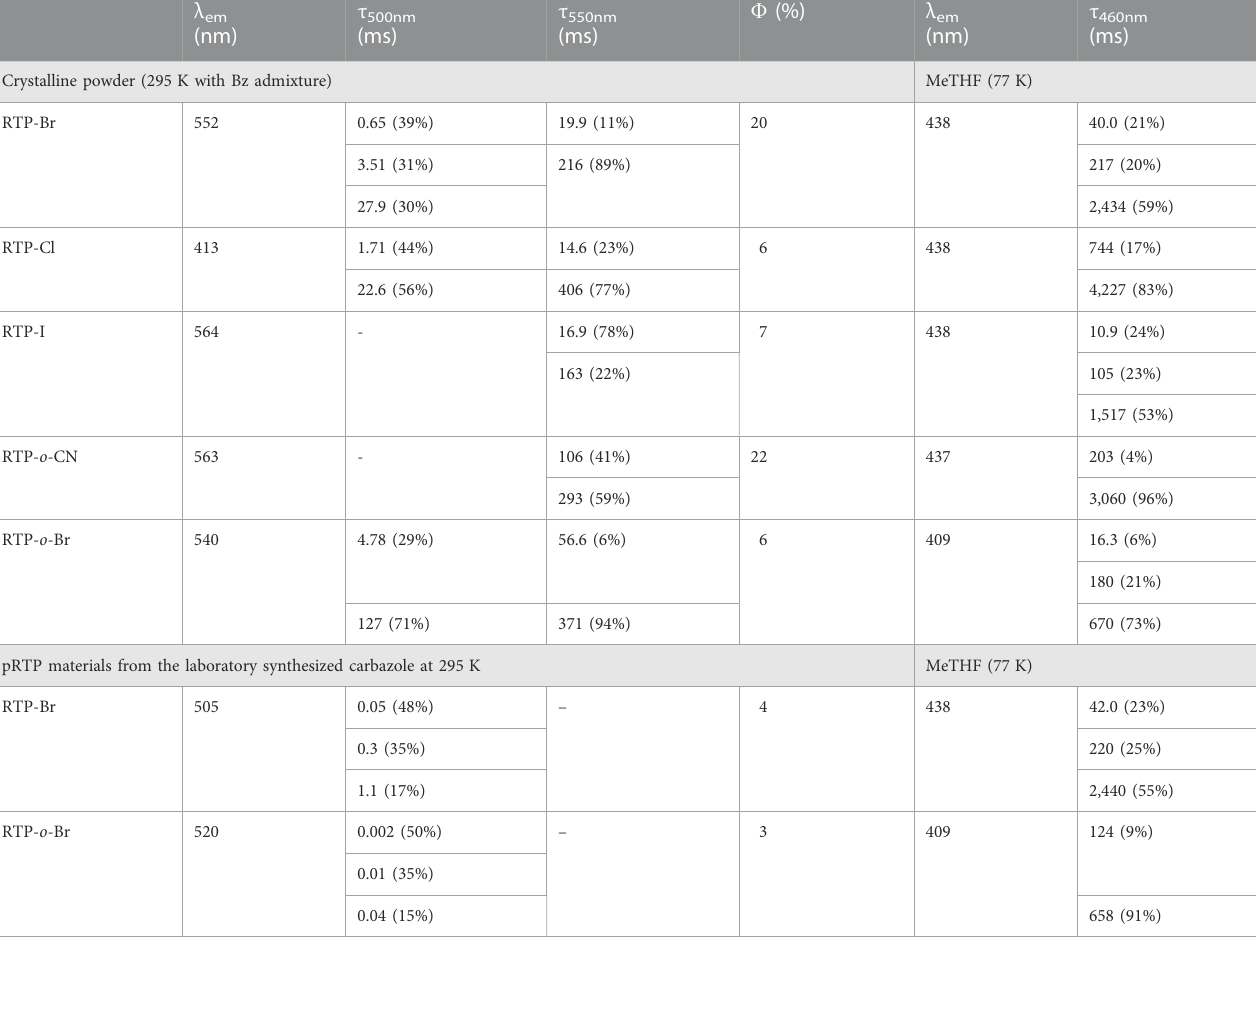
TABLE 2 Photophysical properties in solid state and MeTHF solution.